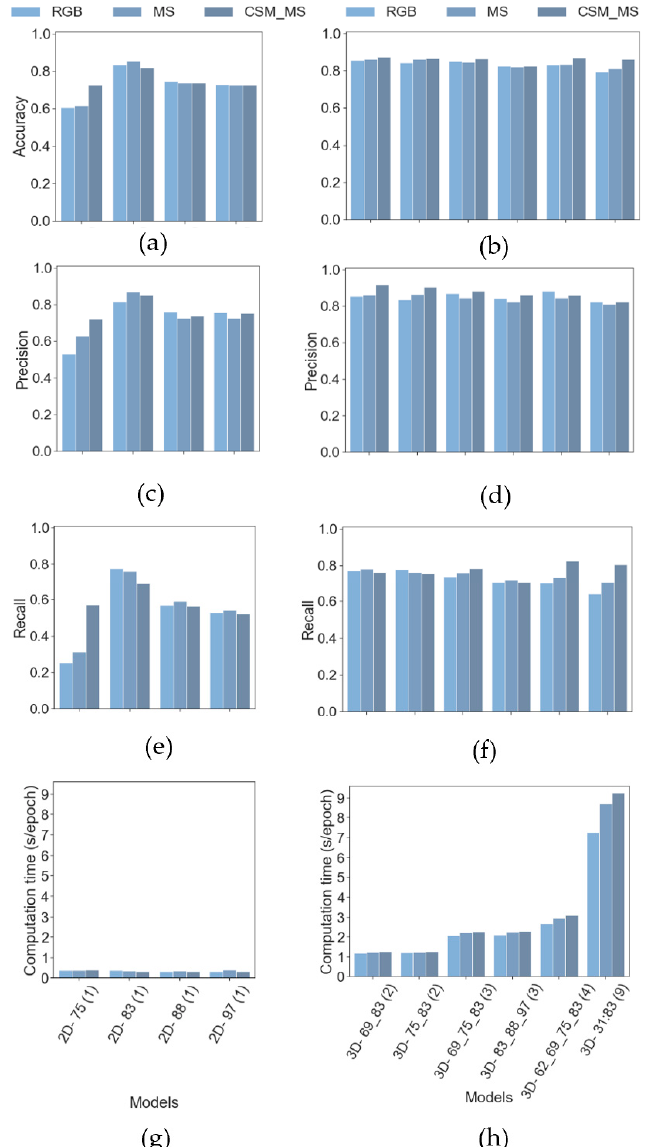
Figure 4. Evaluation of lodging detection prediction in testing data for 2D models by DAP and 3D models by number of time frame sequences considered via OA ( a , b ), Precision ( c , d ) and Recall ( e , f ) metrics. Computation time for 2D-CNN ( g ) and 3D-CNN implementation ( h ) with a batch size of 32 samples for model training step.